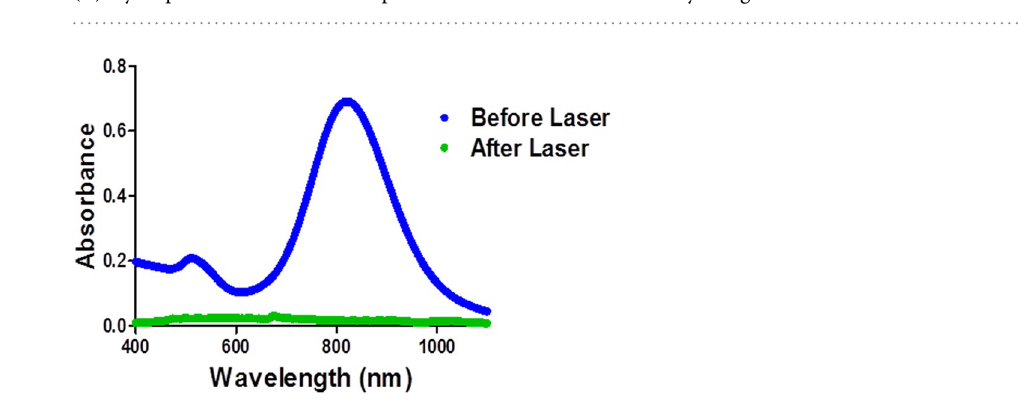
Figure 2. Cartoon demonstrating the different methods employed to evaluate the bactericidal activity of functionalized GNR; ( A ) Hydrophilic PEG-GNR were mixed with bacterial suspension in 96 well plates, while